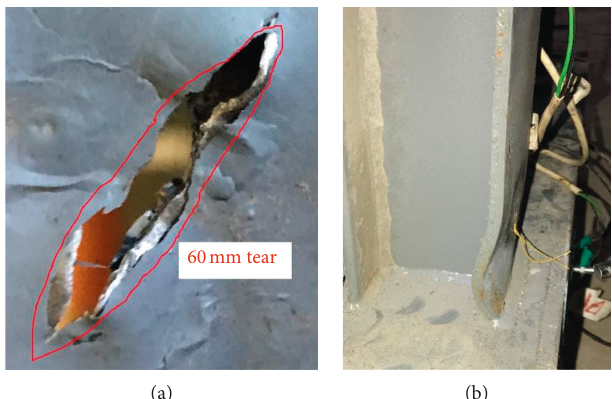
Figure 6: Failure mode of specimen B. (a) Tear at the upper left during the second 12 mm load cycle of and (b) local buckling of the column in